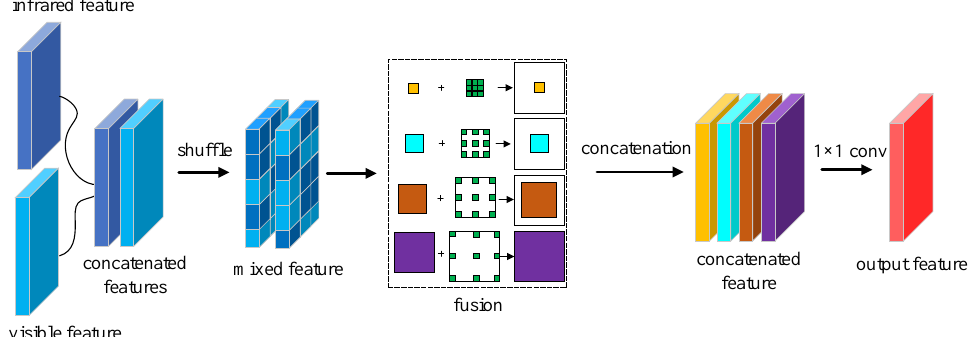
Figure 8. The fusion shuffle module structure where the shuffle is performed before fusion.